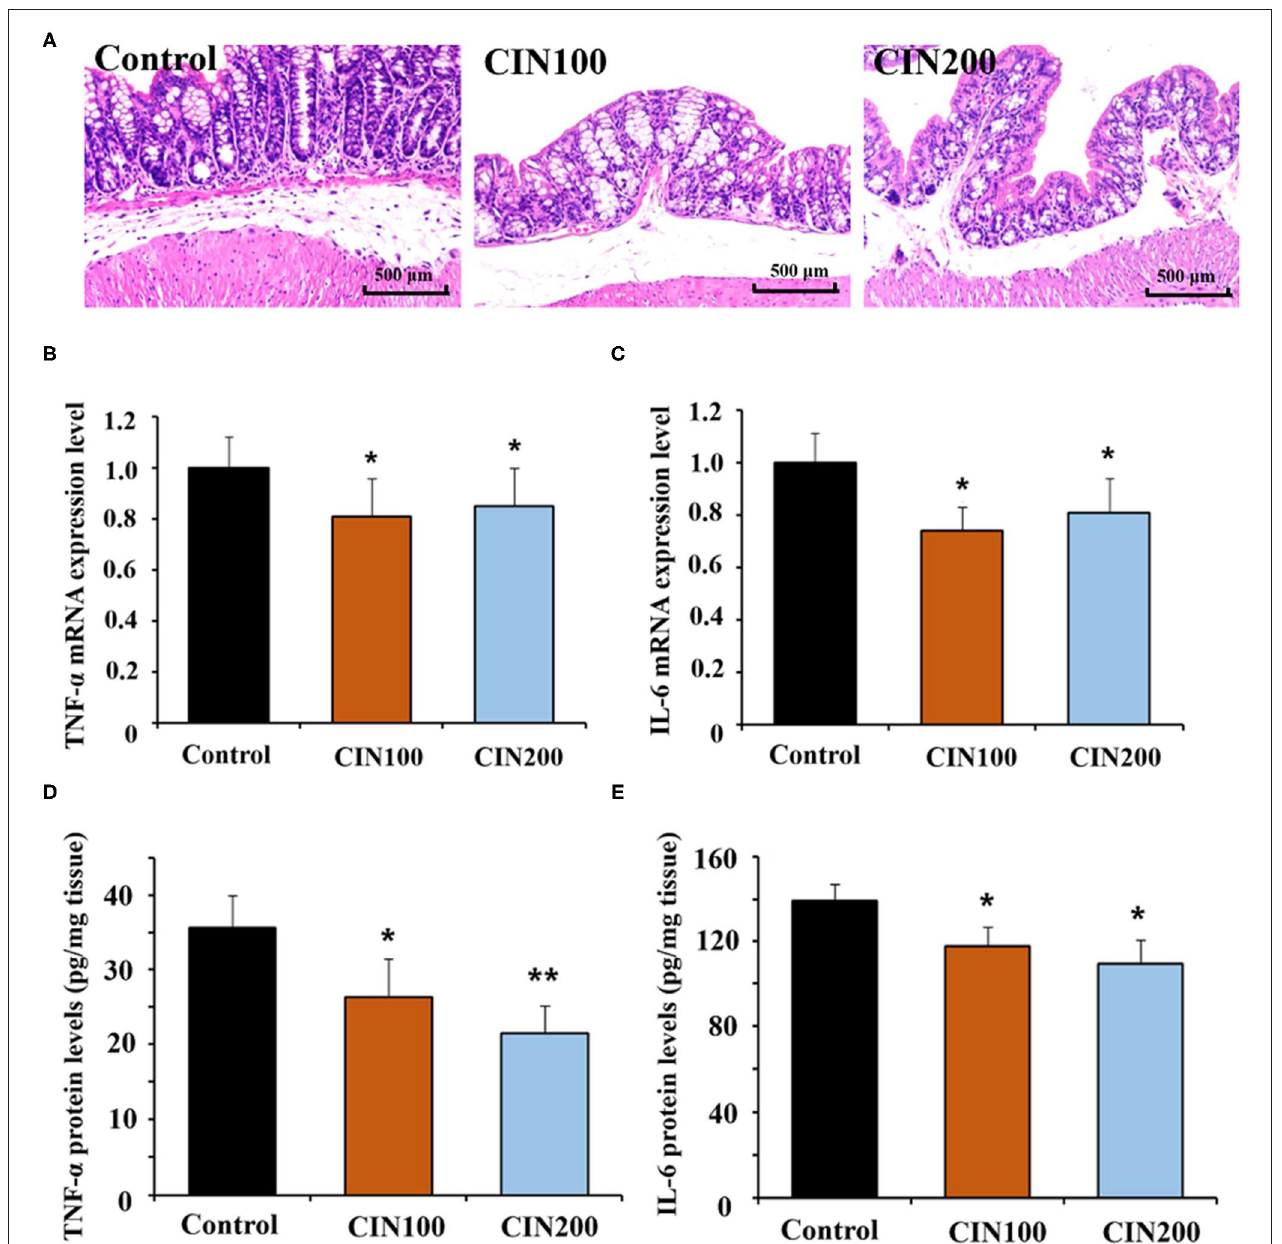
FIGURE 3 | Cinnamaldehyde supplementation attenuates the inflammatory responses in early weaned rat colon. (A) H&E stained distal colon sections from untreated and cinnamaldehyde treated rats at day 7 (Original magnification 100 × ). Inflammation is evident in control group rats. Quantitative RT-PCR was performed to detect the mRNA expression of TNF- α (B) and IL-6 (C) , normalized by GAPDH. ELISA was conducted to measure the production of TNF- α (D) and IL-6 (E) in rat colonic tissues. Data are represented as mean ± SD. * P < 0.05, ** P < 0.01. One-way ANOVA was carried out for each comparison with HSD test.